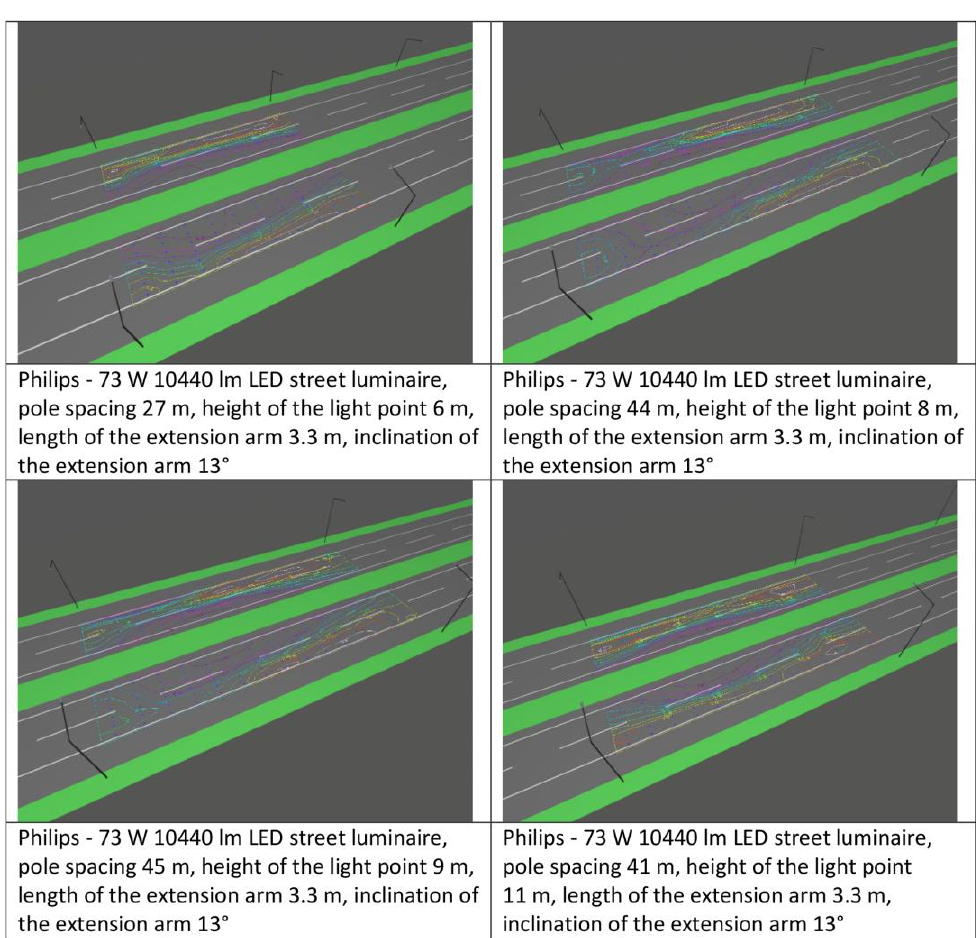
Figure 5. Analysis of the changes in pole spacing due to the height of the light point using the Philips street lamp luminaire as an example (source: original work).